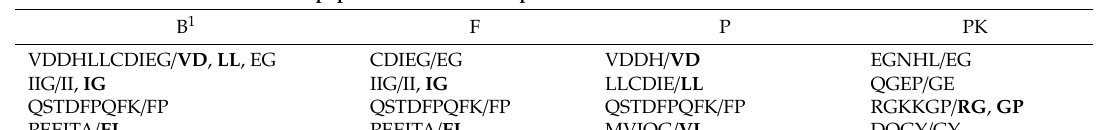
Table A1. Parent peptides released in silico from soybean proteins containing bitter-tasting peptides with and without the indicator status (bold and normal font, respectively). Parent peptides released from profilin due to the simulated action